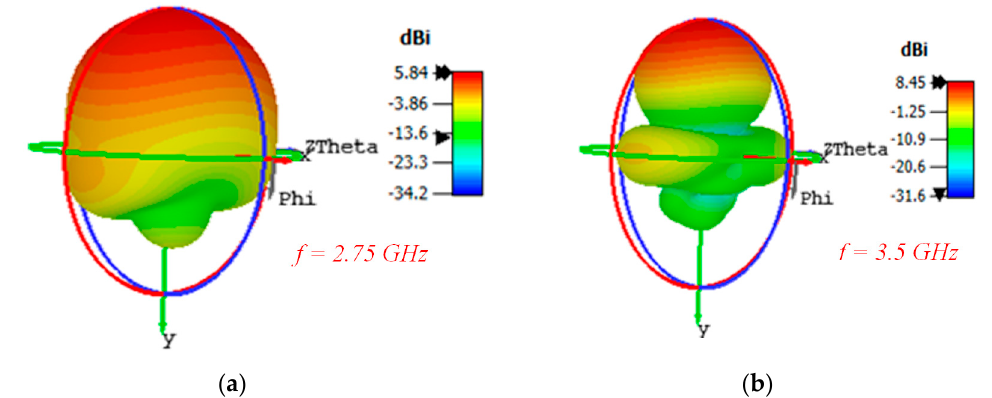
Figure 9. Simulated 3D radiation pattern patterns of the proposed antenna ( a ) f = 2.75 GHz and ( b ) f = 3.5 GHz.